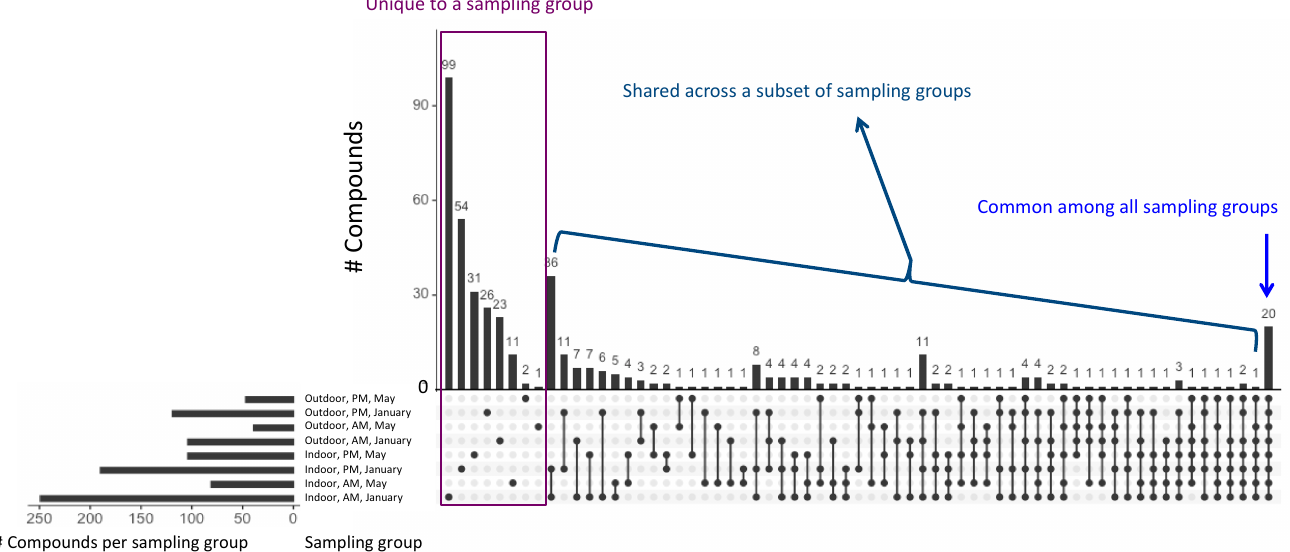
Figure 3. Overlap of the compounds measured in each of the different sampling groups ( n = 8) for all compounds detected at least once above the limit of quantitation (2 µgm − 3 ). The number of compounds measured in each sampling group is indicated in the bottom left. Black dots indicate that the bar applies to that sampling group. For example, 36 compounds were measured indoors in January during both the AM and PM sampling sessions, but these 36 compounds were not measured in any other sampling group.